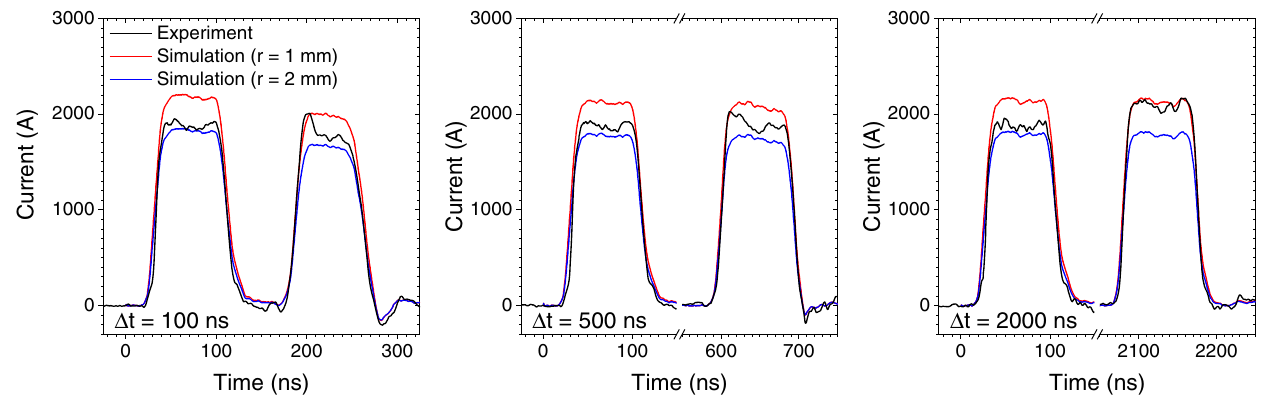
FIG. 7. Comparison of simulated and experimental extracted currents for different Δ t . Red and blue curves represent simulated current for a recess r of 1 and 2 mm, respectively. Black curves correspond to experimental measurements of the extracted current. Note that the timescales are